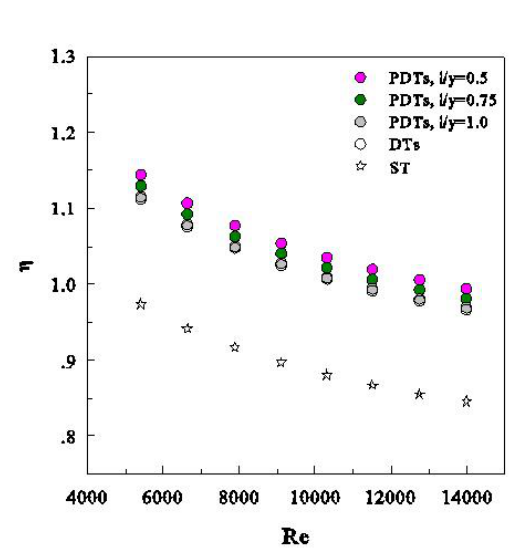
Figure 9: Thermal performance factor against Reynolds number for